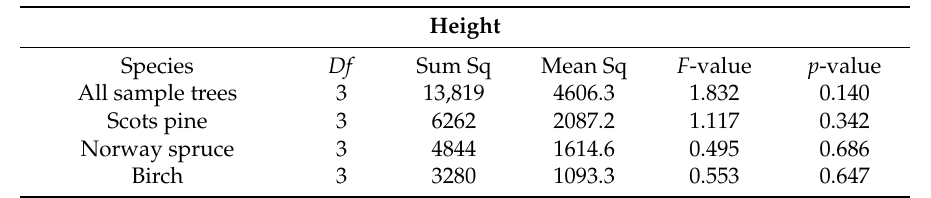
Table 3. The results of ANOVA analysis for tree height measurements for all sample trees as well as for different tree species with degrees of freedom ( Df ), sum of squares (Sum Sq), mean squared error (Mean Sq), F -value and p -value.